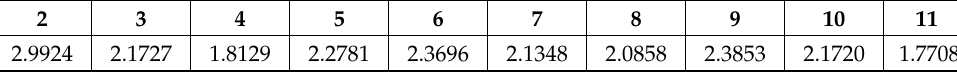
Table 6. Mean absorption time ( m ) , states 2 to 11. Source: Authors’ own